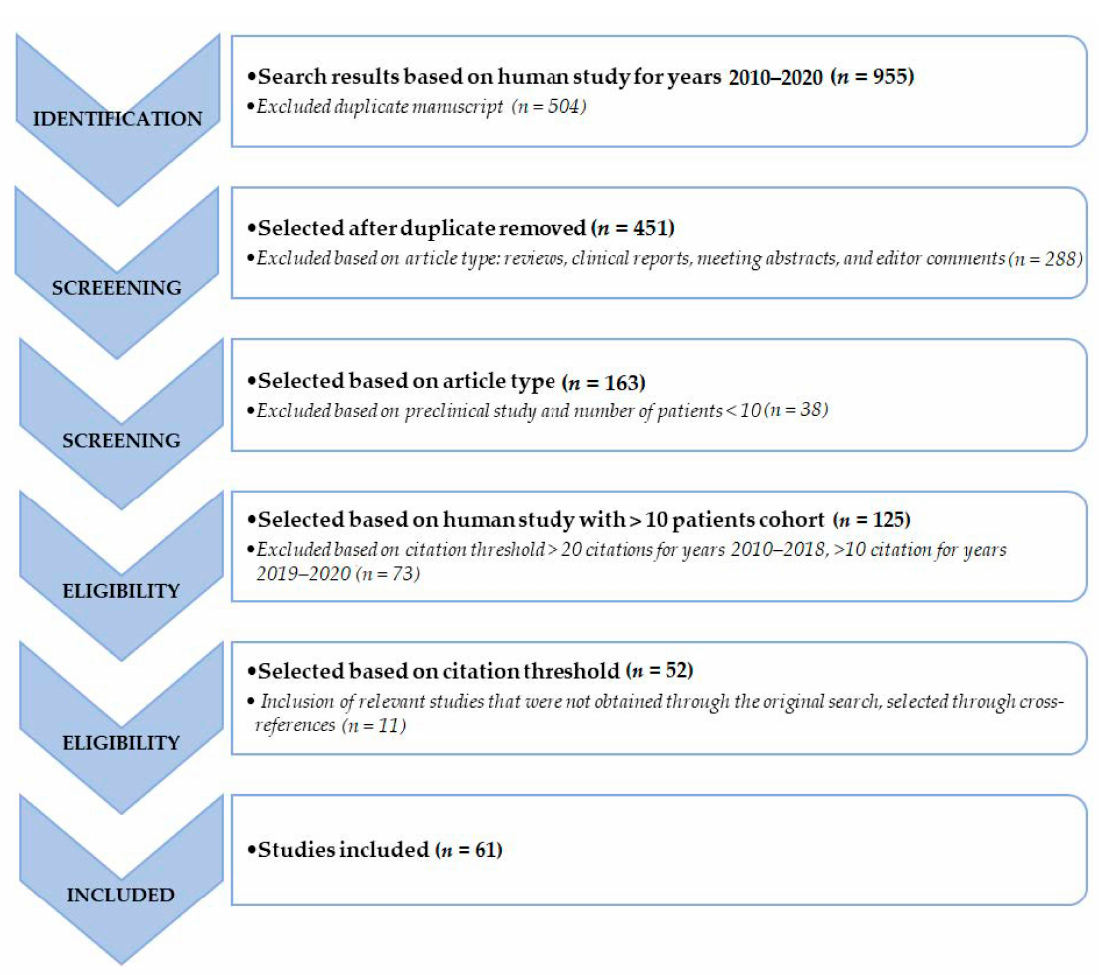
Figure 1. Schematic representation of the performed literature search and the review